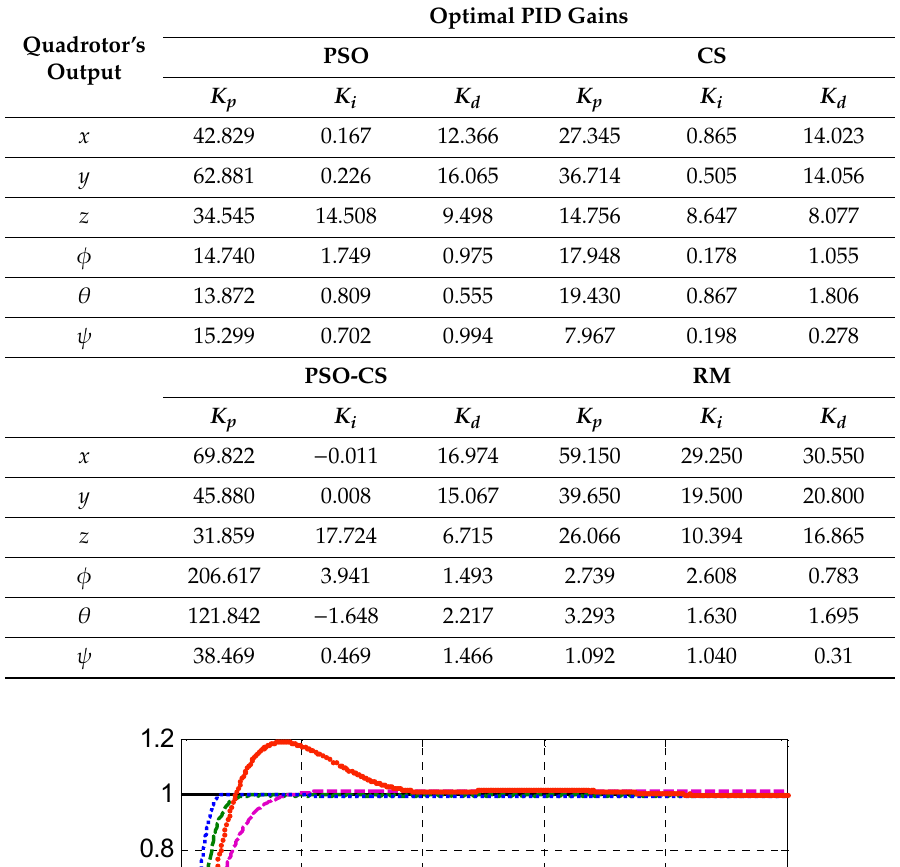
Table 3. Optimal Proportional, Integral and Derivative (PID) parameters obtained with Particle Swarm Optimization (PSO), Cuckoo Search (CS), Particle Swarm Optimization-Cuckoo Search (PSO- CS), and Reference Model (RM) for the quadrotor.